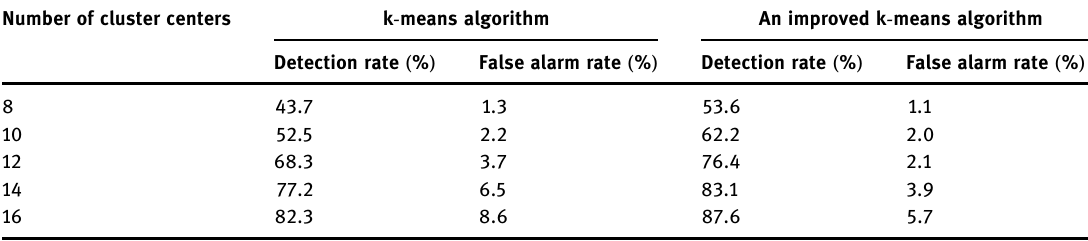
Table 3: Performance table after algorithm improvement Number of cluster